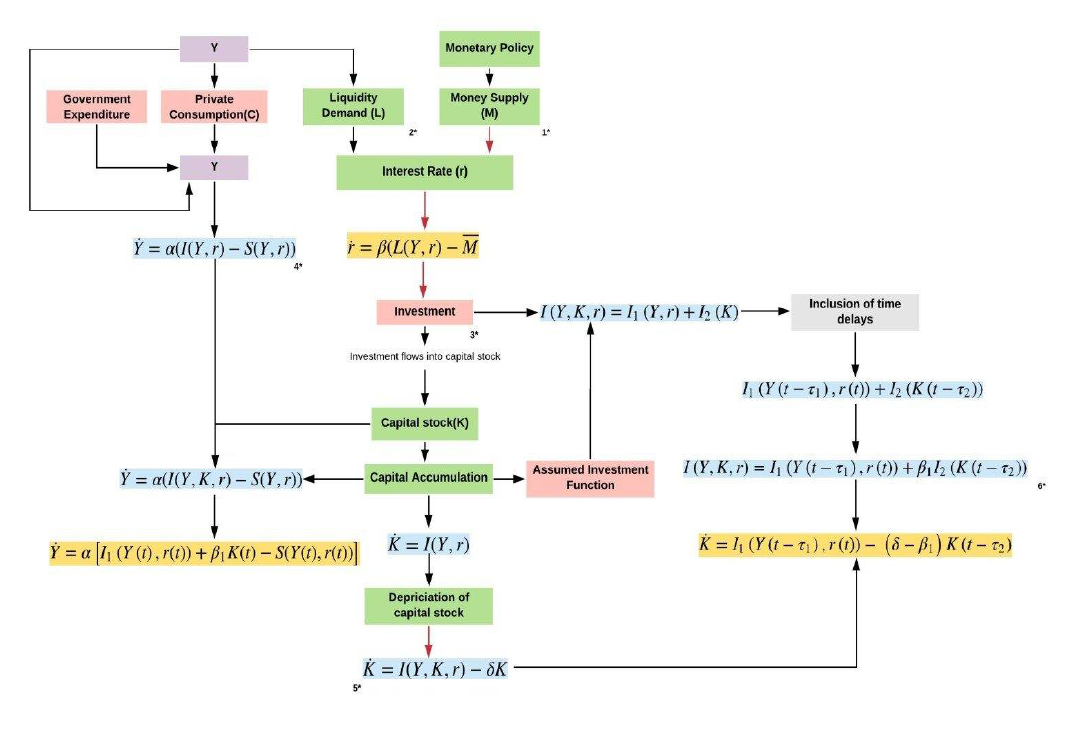
Figure 1. Macroeconomic